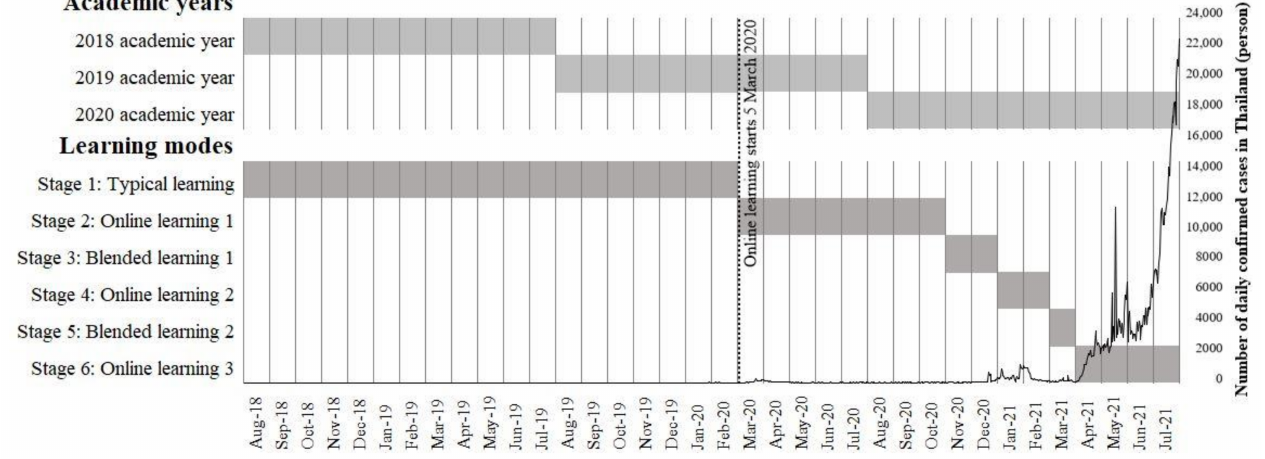
Figure 2. Outbreak trend of the COVID-19 pandemic with periods of the temporary closure of the university during academic year 2018 to 2020, alongside the online and blended learning mode implications from stage 1 to